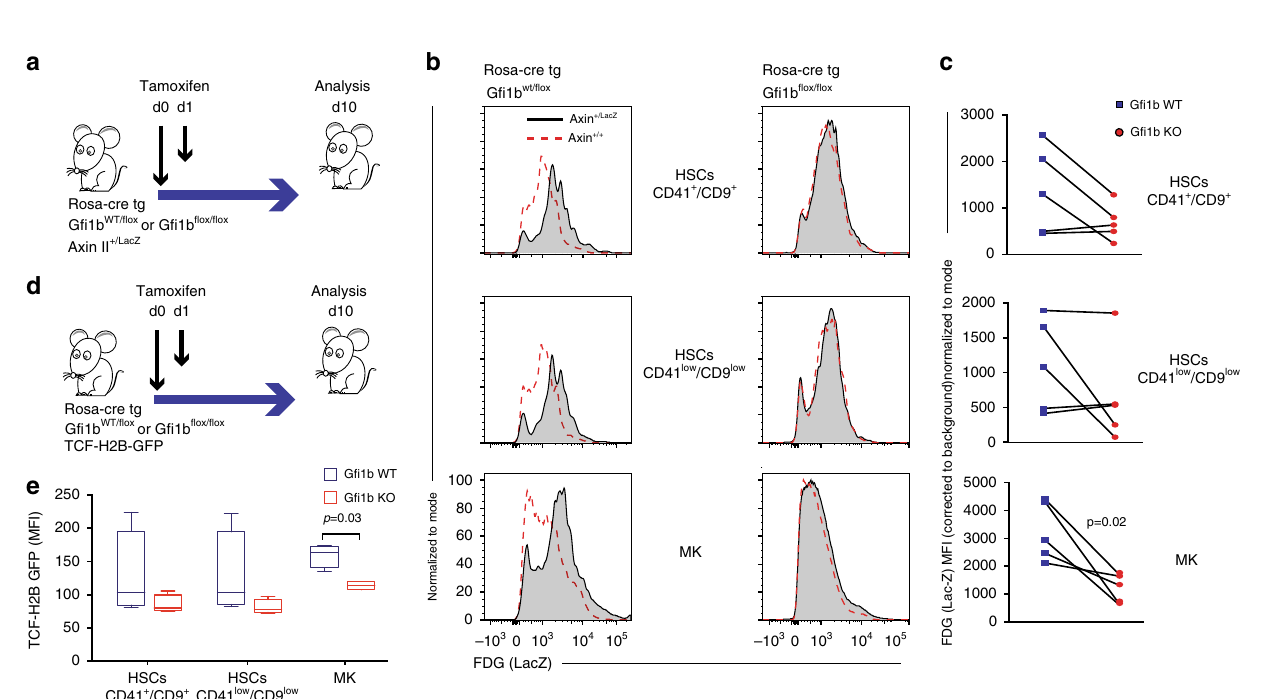
Fig. 5 G fi 1b is required for the expression of Axin II- or TCF-dependent reporter alleles in HSCs and MKs in vivo ( a – c ) Axin2 + /LacZ Wnt-reporter mice were used. Littermates not carrying the reporter transgene (Axin2 + / + ) were used to correct for endogenous β -galactosidase activity. a Mice were analysed by FACS at day 10 following the fi rst injection of tamoxifen. b FDG (LacZ staining) histograms of indicated FACS gated cells. A representative result from three independent experiments is shown. c Quanti fi cation of the mean fl uorescence intensity (MFI) measured in the FDG channel (LacZ) normalized to endogenous β -galactosidase activity. Paired t-test was used for the analysis. ( n = 5 mice per group) ( d , e ) In vivo measurement of canonical Wnt signaling activity in G fi 1b WT/KO MKs and HSCs by FACS using TCF-H2B-GFP transgene reporter mice. A Mann – Whitney U non-parametric test was used for the analysis. Boxplot Centre line shows median and bounds of box and whiskers show interquartile ranges of GFP MFI, n = 5 GFI1b WT and fi ve GFI1B KO